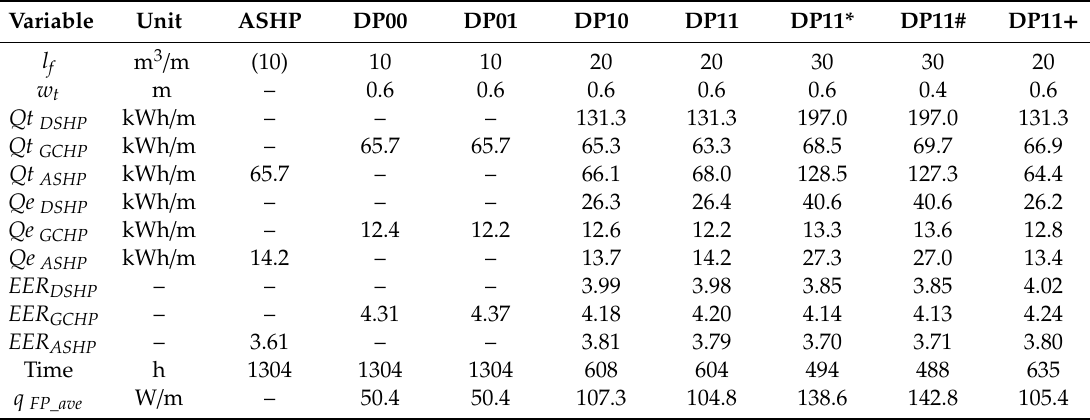
Table 4. Summary of energy performance for the di ff erent case studies in